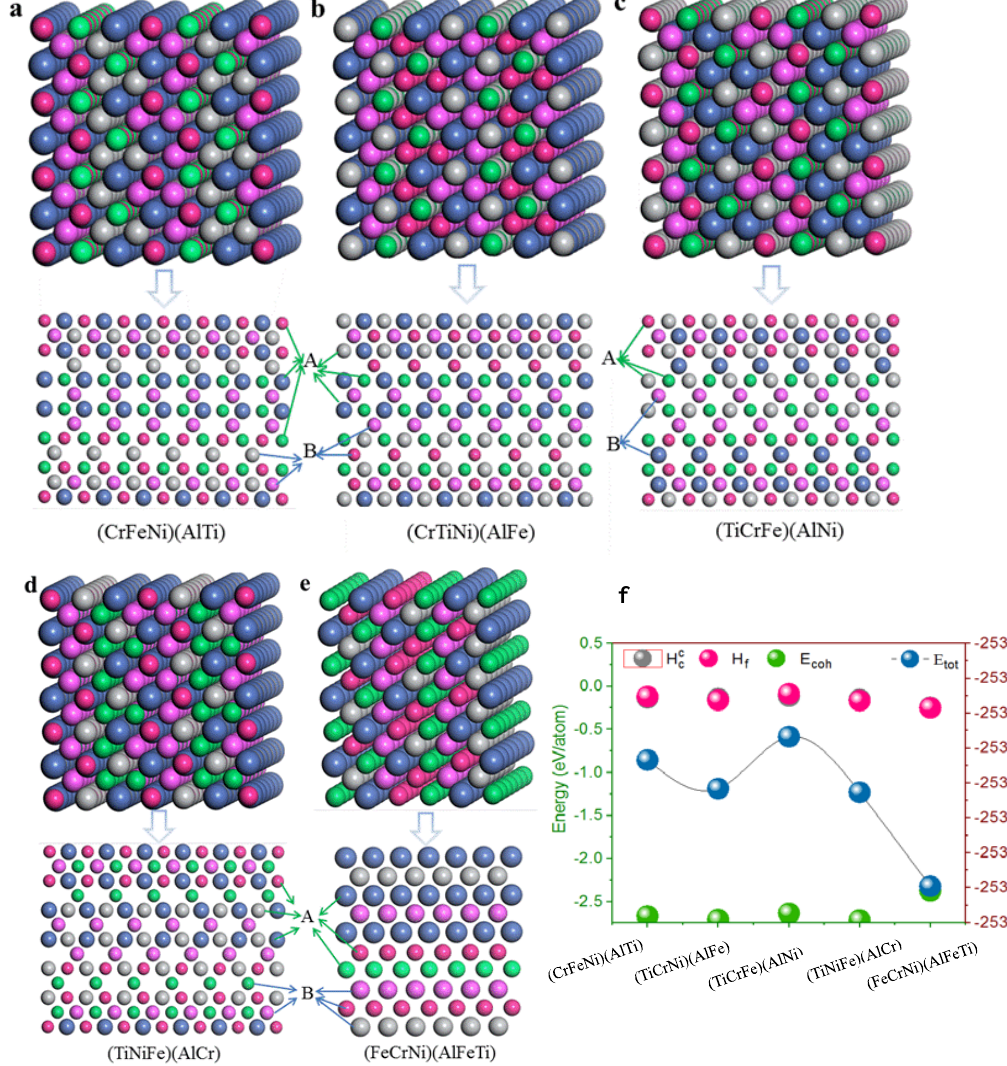
Figure 2. Schematic representation of crystal cell, (110) plane for single-phase AlCrTiFeNi of different atom occupancy positions (‘A’ and ‘B’ represent the atoms position in parentheses: ( a ) (CrFeNi)(AlTi); ( b ) (CrTiNi)(AlFe); ( c ) (TiCrFe)(AlNi); ( d ) (TiCrFe)(AlCr); ( e ) (FeCrNi)(AlFeTi); ( f ) The calculated total energy E tot , formation enthalpy H f , cohesive energy E c , and secondary solid solution formation enthalpy H c c .